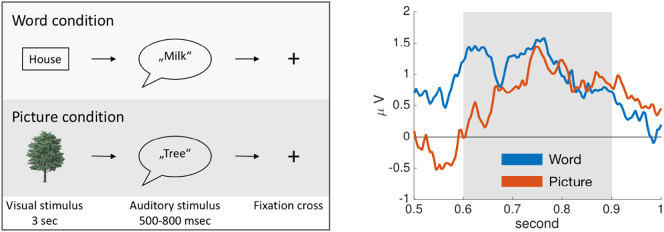
Left: The ERP paradigm consists of a word and a picture processing task. Each task begins with a visual stimulus followed by an auditory stimulus. At the fixation cross the children decide whether it is a congruent or an incongruent pair. Right: Illustration of average EEG recordings in the control group for the word and picture condition. As a measure of the late positive component, we average the activity in the window from 600 to 900 msec.